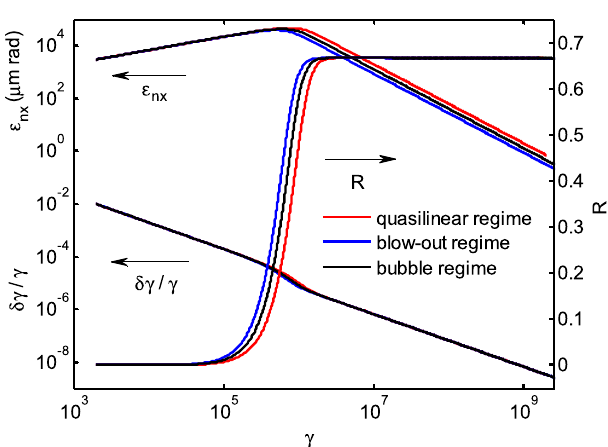
FIG. 3. Evolutions of normalized transverse emittances " , nx energy spreads (cid:11)(cid:8)=(cid:8) , and relative radiation loss rate R of =E and focusing Fig. 2 for different acceleration gradients E ffiffiffi p z 0 ¼ ¼ 0 : 56 , and K=k ¼ 0 : 35 =E , i.e. a 2 , E constants K=k p z p 0 0 ¼ 4 , E ¼ 2 , and =E for the quasilinear regime (red lines), a ffiffiffi p z 0 0 ¼ 1 ¼ 9 , K=k 2 for the blow-out regime (blue lines), and a ffiffiffi p p 0 ¼ 3 , and K=k ¼ 1 = E =E 2 for the bubble regime (black z p 0 lines), respectively, as a function of the beam energy (cid:8)